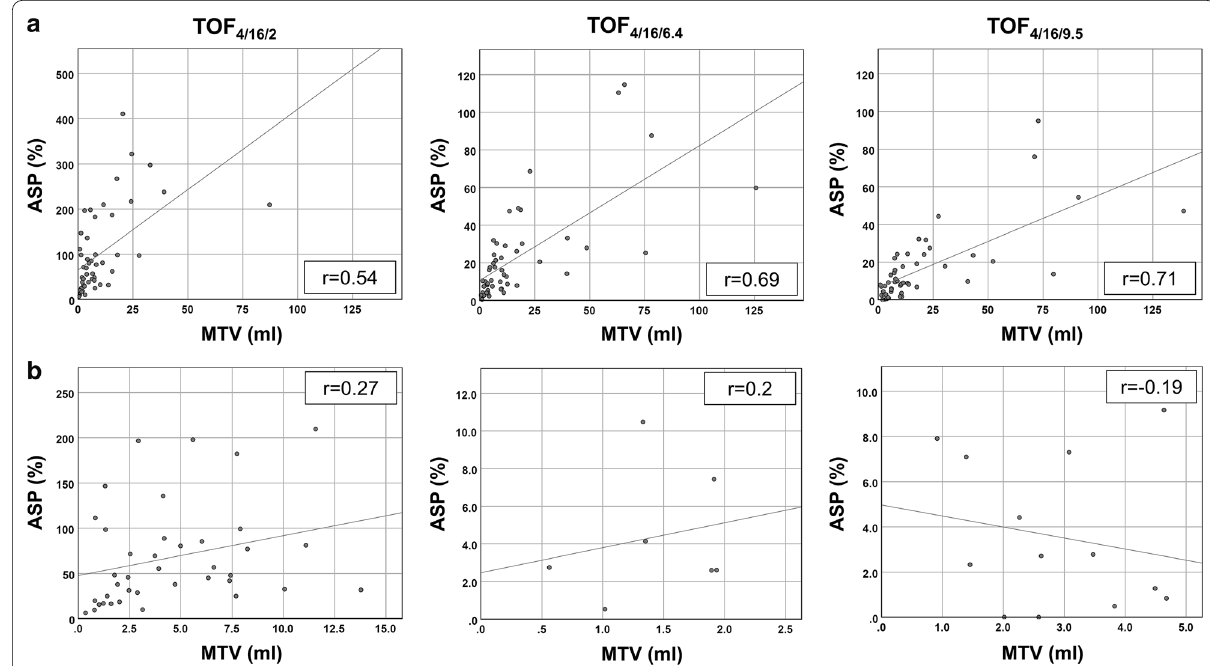
Fig. 4 Correlation plots for ASP and MTV. Correlation plots for ASP and MTV for the three TOF 4/16 algorithms. a shows plots for all patients. Correlation was moderate with TOF 4/16/2 and moderate to high with TOF 4/16/6.4 and TOF 4/16/9.5 . b Correlation was negligible ( r < 0.3) in lesions with MTV 15 ml for TOF 4/16/2 , while the threshold was lower for TOF 4/16/6.4 (MTV ≤ of ASP and MTV in smaller lesions results from the limited spatial resolution. With TOF 4/16/2 , high noise level contributes to the high MTV threshold for correlation. With TOF 4/16/9.5 , the poorer reconstructed spatial resolution may contribute to the higher MTV threshold compared to TOF